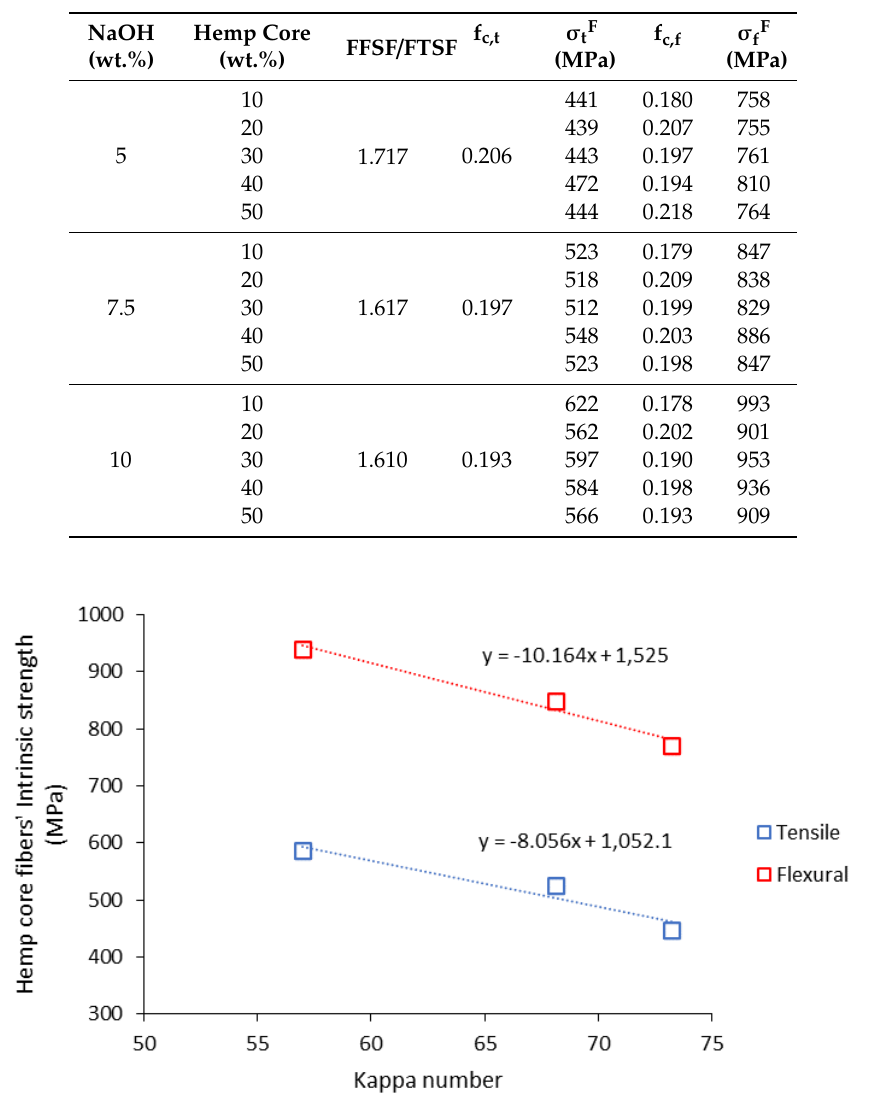
Figure 8. Intrinsic strengths of hemp core fibers with the kappa number.